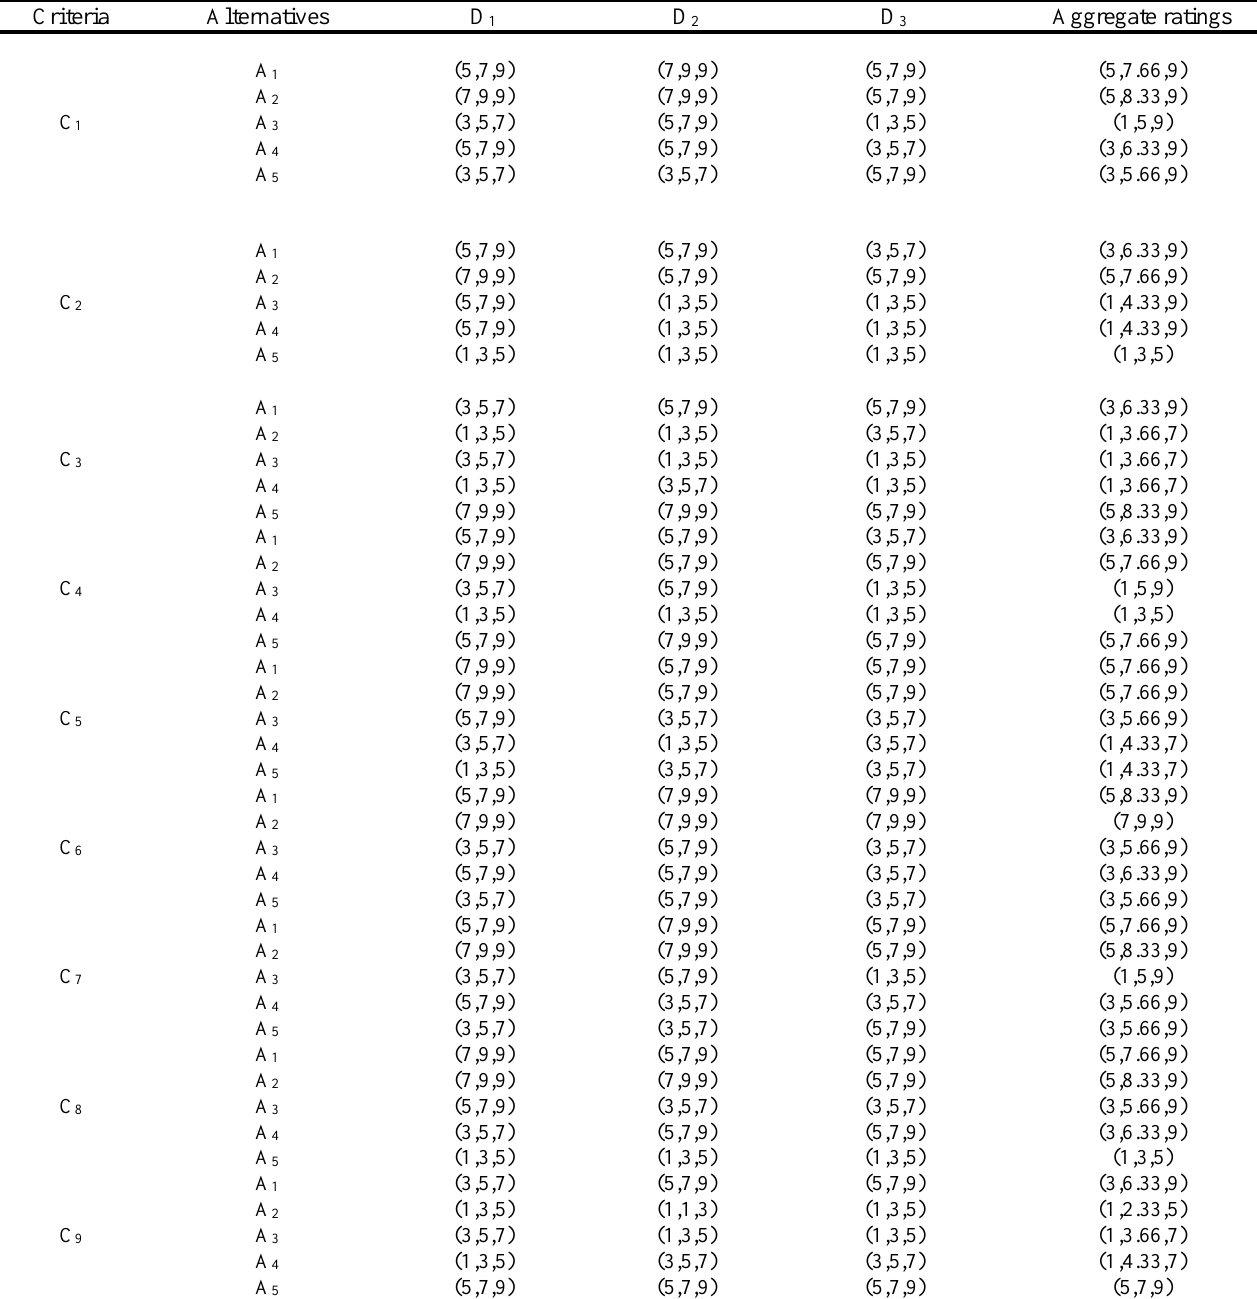
Table 6. Aggregate fuzzy weight for